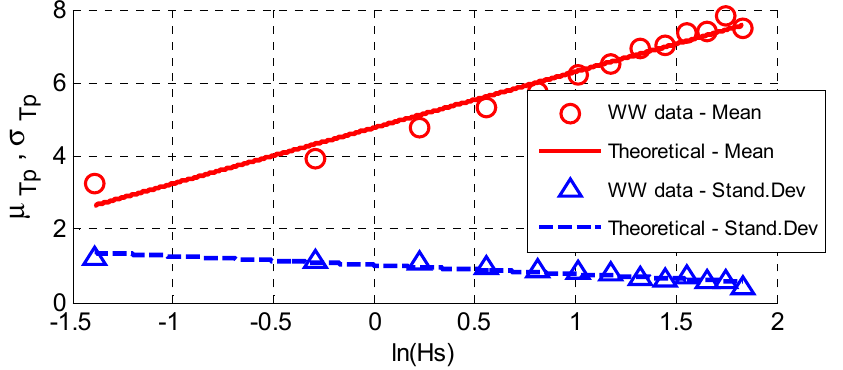
Figure 8. Mean and standard deviation for calculation of Tp distribution across Hs bin range; E 14.5–N 44.0. The model parameters for the joint distribution of significant wave height and peak pe- riod are finally presented in Table 3 for regions, and Figures 9 and 10 for individual locations. Table 3. Model parameters for joint distribution of Hs and Tp . Adriatic regional subdivision. Region Central Adriatic